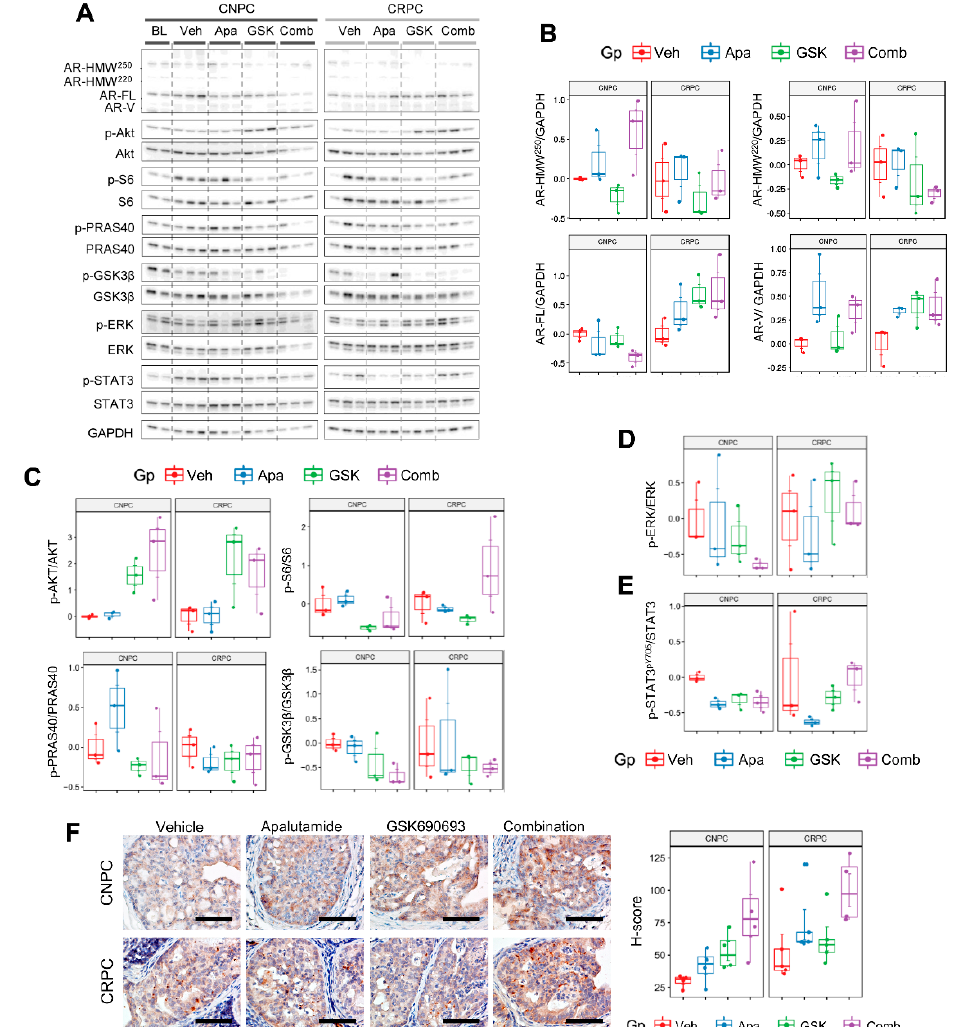
Figure 7. Molecular characterization of response to apalutamide/GSK690693 combination therapy in Pten -deficient prostate cancer. ( A ) A subset of Pten -deficient castration-naïve prostate cancer (CNPC) and castration-resistant prostate cancer (CRPC) samples from Figure 6A,B ( n = 3 mice/group) were used to profile ( B ) full-length androgen receptor AR (AR-FL), aberrant AR (AR splicing variant (AR-V), AR high-molecular weight (AR-HMW)) and the signaling molecules associated with ( C ) PI3K/AKT, ( D ) MAPK and ( E ) STAT3 signaling by Western blot. Samples were collected four hours after the last treatment dose. Semiquantitative densitometric analysis was performed in ImageJ; proteins were first normalized to GAPDH and phosphorylated proteins were normalized to total protein. ( F ) Immunohistochemical visualization and quantification of PIM-1 expression in Pten -deficient prostate cancer after treatments with apalutamide and GSK690693 as monotherapy and combination therapy. Plots represent the PIM-1 H-scores in cancer cells as determined by QuPath. Horizontal bars represent the mean ± SE, center lines show the medians and box limits indicate the 25th and 75th percentiles, and the violin plots show the distribution where circles represent the individual samples. Scale bars = 100 μ m.